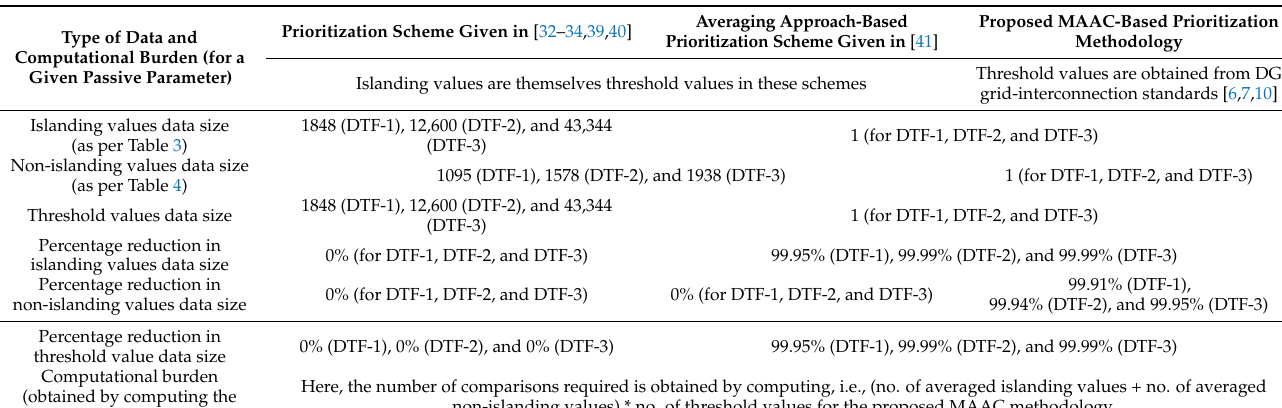
Table 8. Reduction in data size and computational